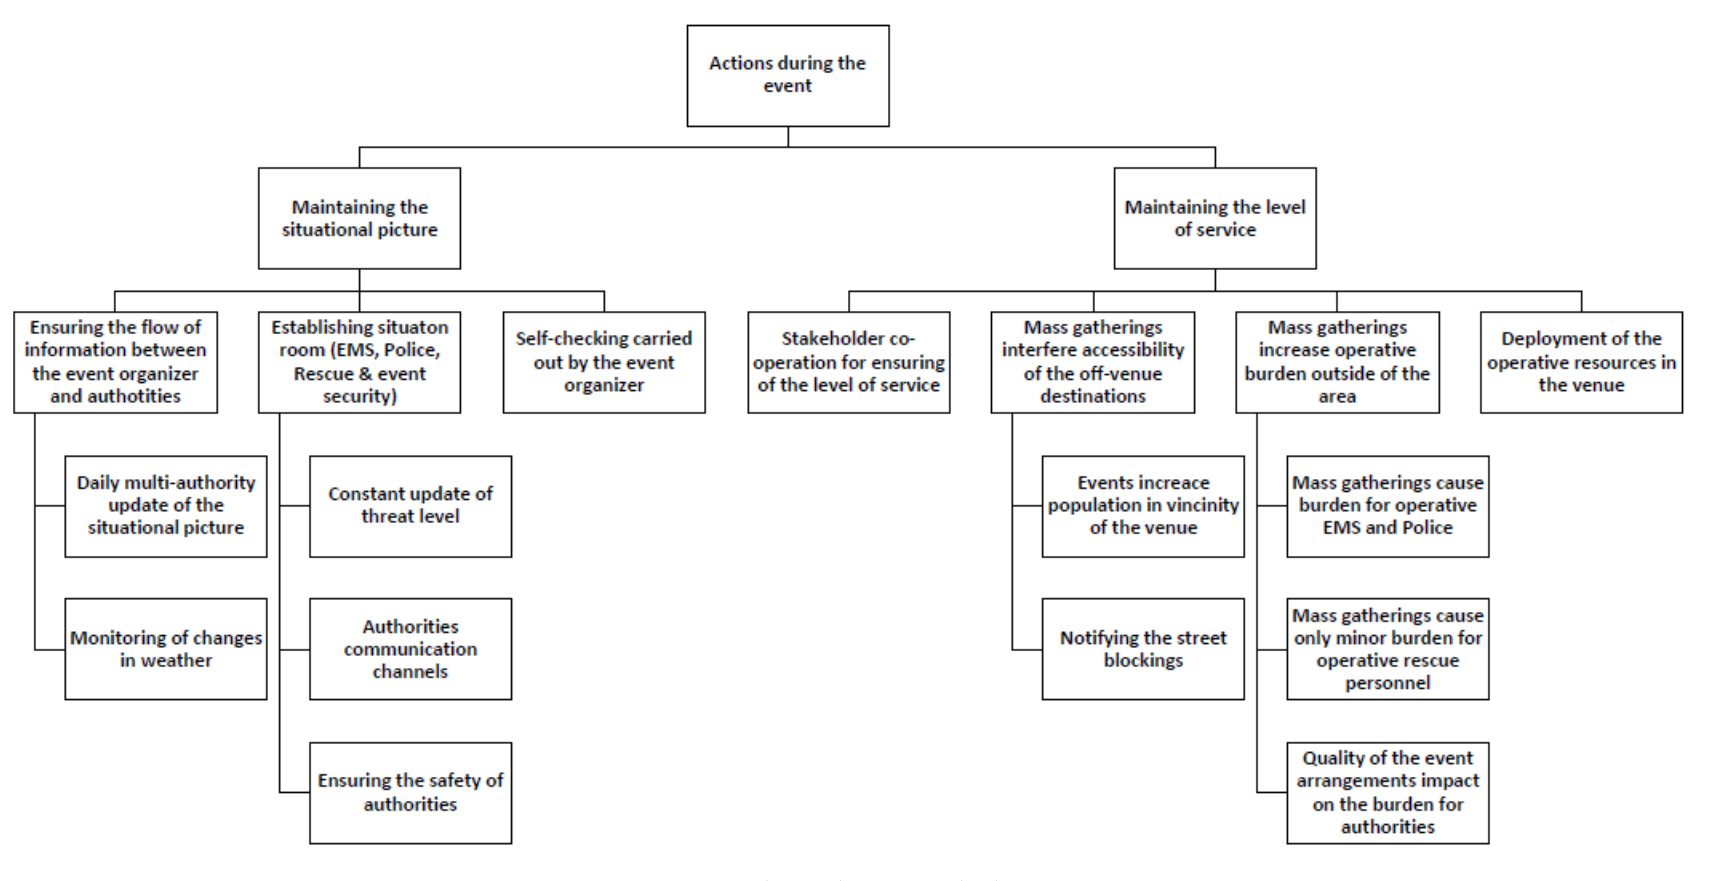
Figure 4. Actions during the event and sub-categories.